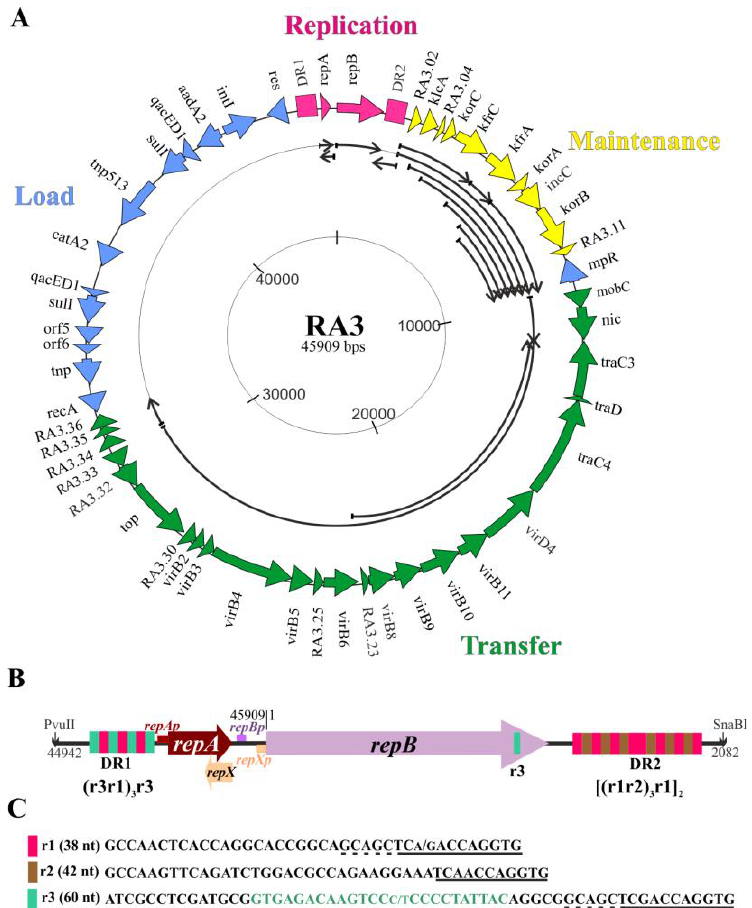
Figure 1. RA3 map (DQ401103). ( A ) Transcriptional organization. The ORFs are indicated by thick arrows pointing out the direction of transcription. Long direct repeats in the replication module are symbolized by rectangulars. Functional modules are labelled with different colors: replication in red, maintenance in yellow, conjugative transfer in green, and load (mainly In10) in blue. Thin arrows in the inner circle demonstrate the experimentally confirmed transcripts from the RA3 backbone. ( B ) Close-up of the replication module between PvuII and SnaBI restriction sites (3039 bp). Note that the annotation of the RA3 genome starts from the ATG codon of repB [9]. Promoters identified in the module are indicated by small boxes [9]. Long direct repeats DR1 and DR2 are built of the three repetitive motifs r1, r2, and r3 according to the formulas below the schemes. ( C ) DNA sequences of the repetitive motifs. The sequences conserved in all motifs are underlined. Part of r3 present in the 3′ end of the repB is shown in green.